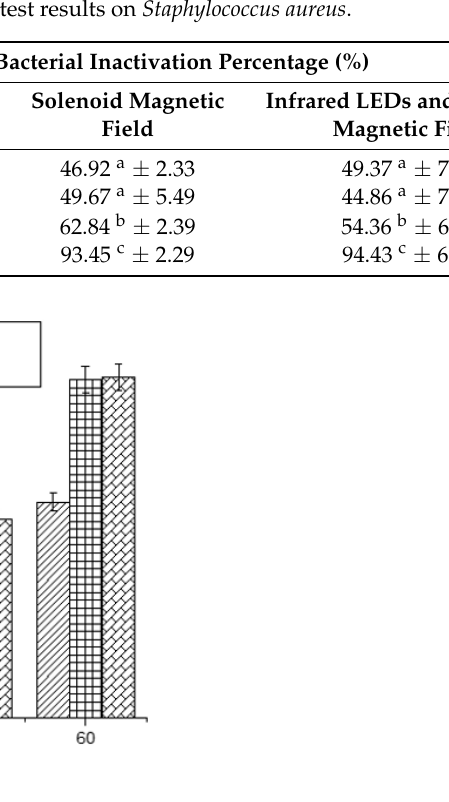
Figure 12. Graph of the percentage of inactivation of S. aureus against time from treatment results . Table 4. Table of conclusions of statistical test results on Staphylococcus aureus. Time